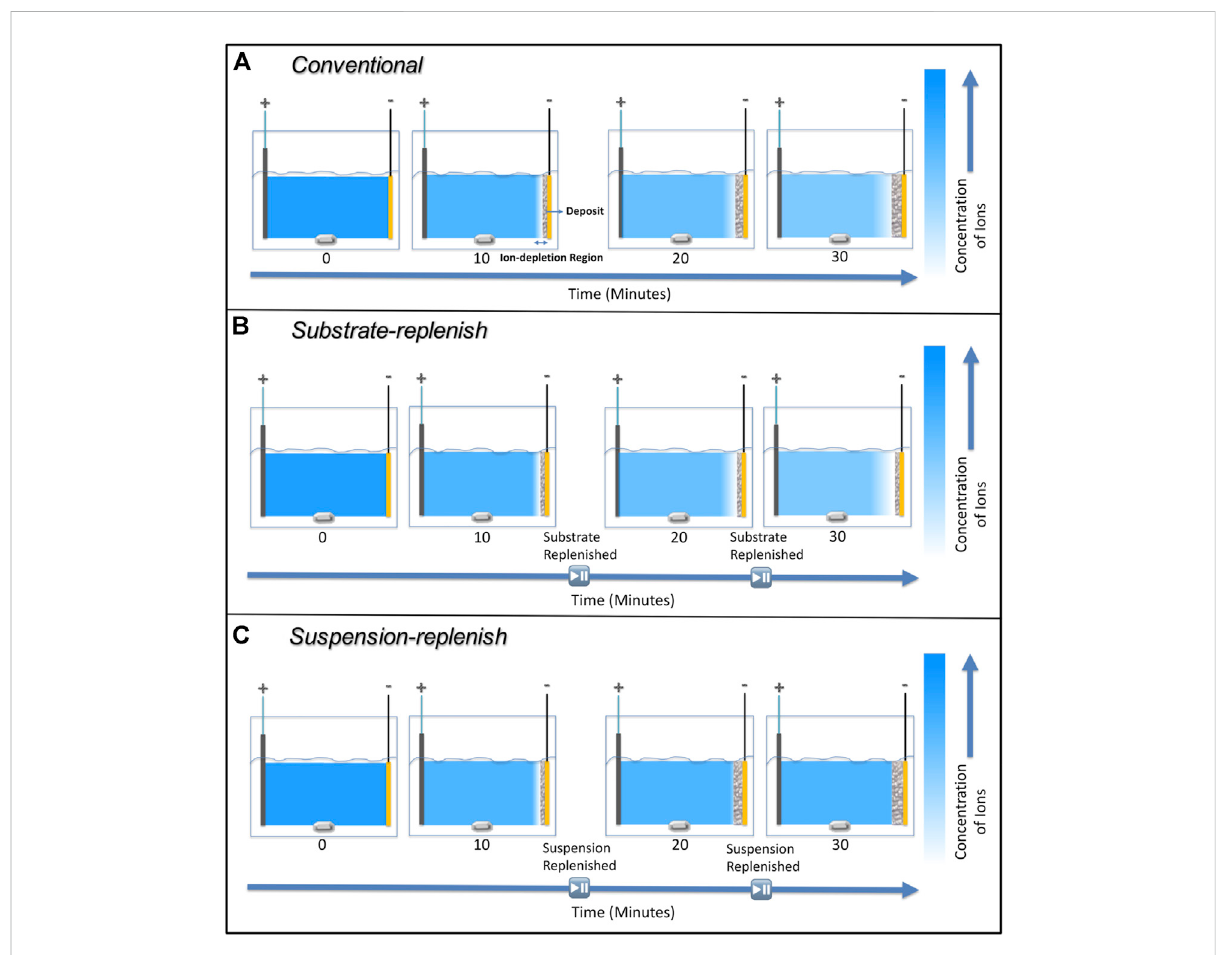
FIGURE 7 Schematic showing the ion-depletion region and deposit growth on the substrate during (A) conventional electrophoretic deposition, (B) substrate-replenish electrophoretic deposition, and (C) suspension-replenish electrophoretic deposition.